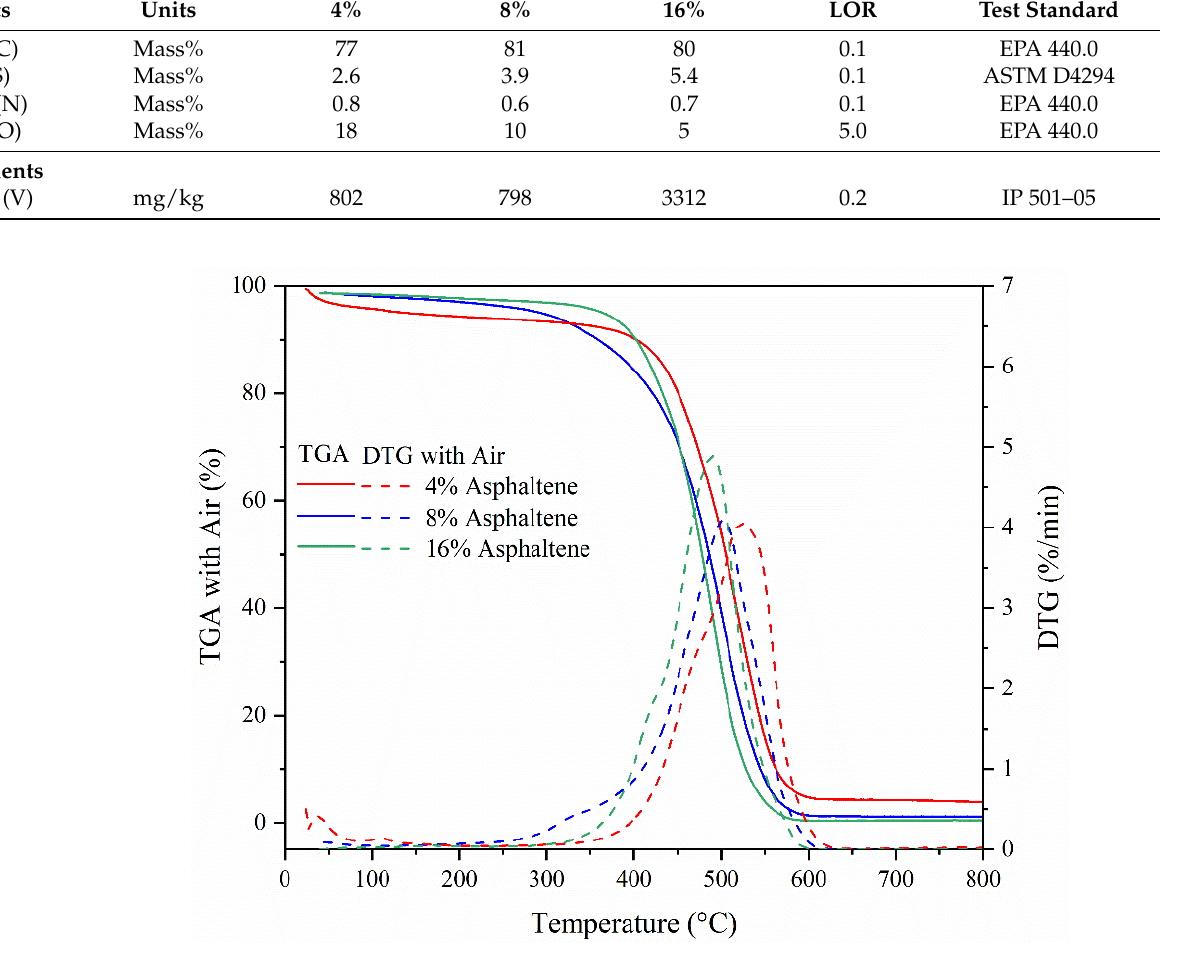
Figure 11. TGA and DTG distribution of solid particle emissions.